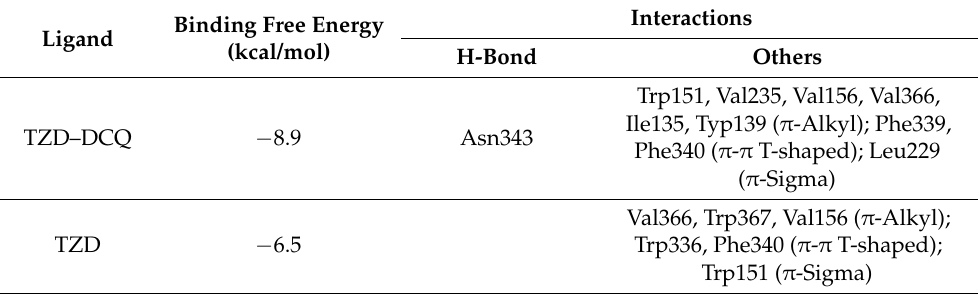
Table 2. Interactions data of TZD–DCQ or TZD alone against serotonin (PDB ID: 6BQH).